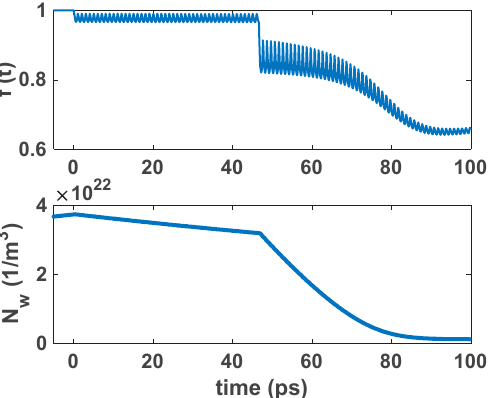
Figure 9. The GS and WL dynamics for a 5 Tb s − 1 input bit sequence in the EP method. The input signal power is 20 mW.